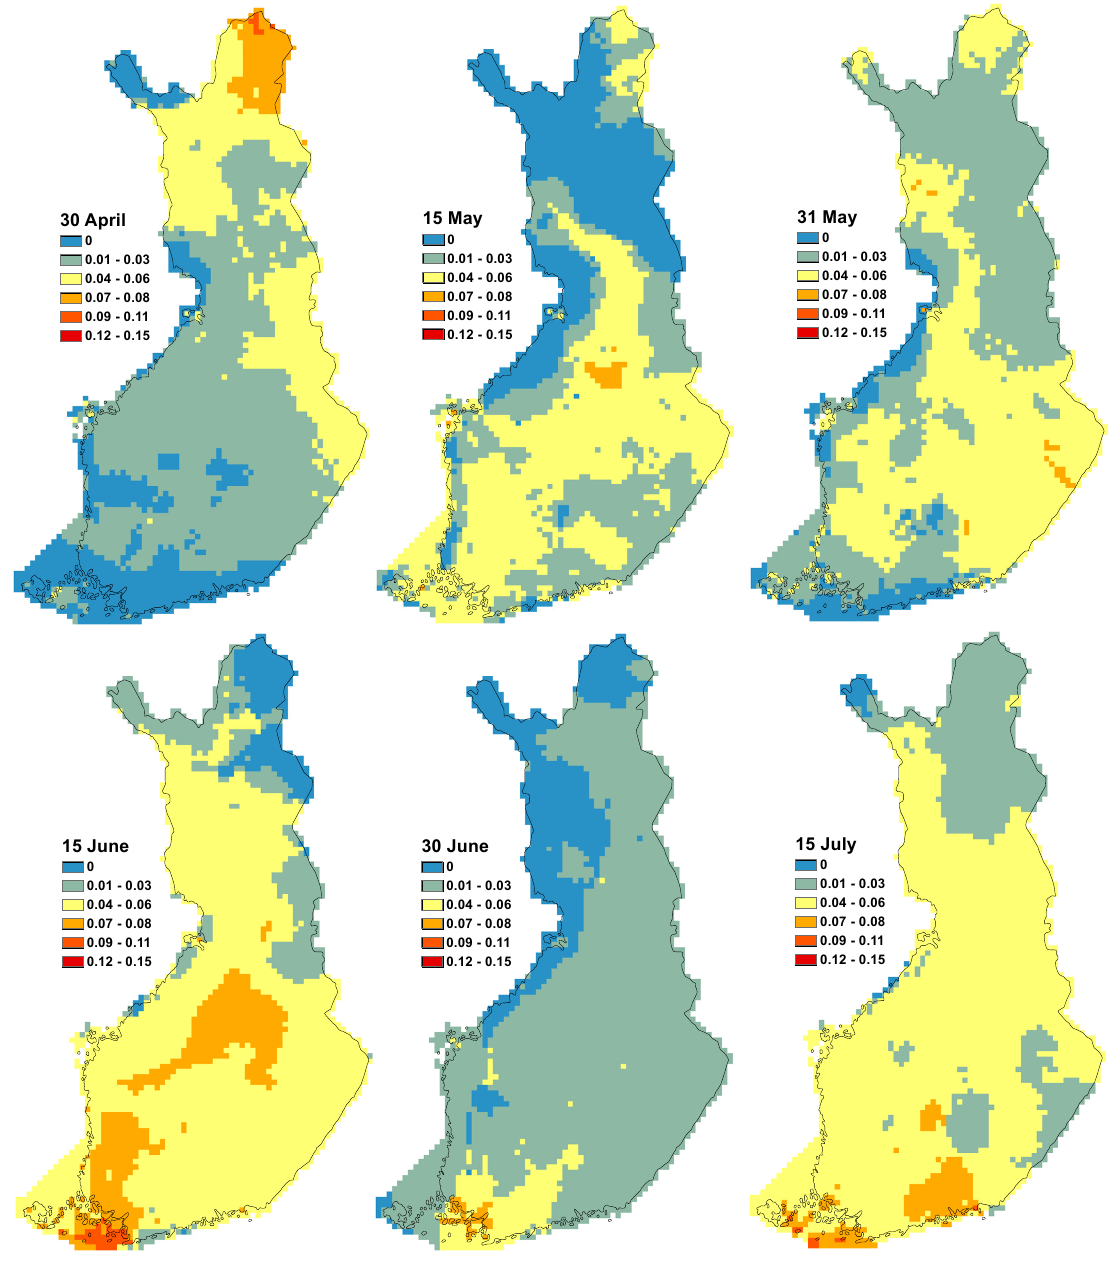
Fig. 3a. Probabilities of elevated temperatures of ≥1 °C that lasted for at least three weeks for the periods that ended on 30 April to 15